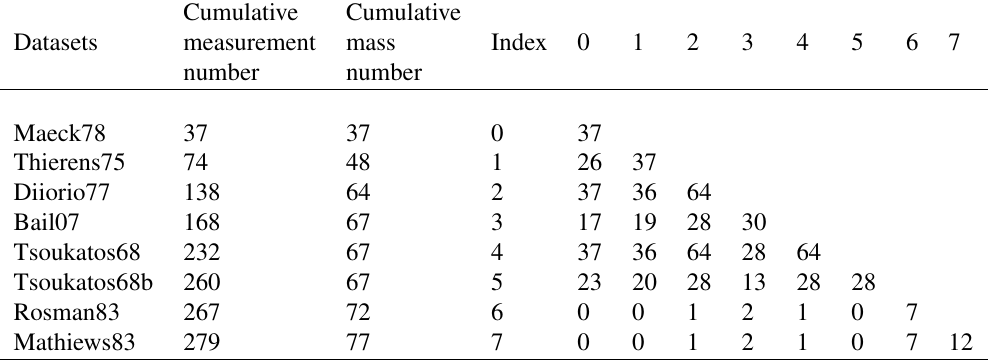
for the 8 datasets selected. A